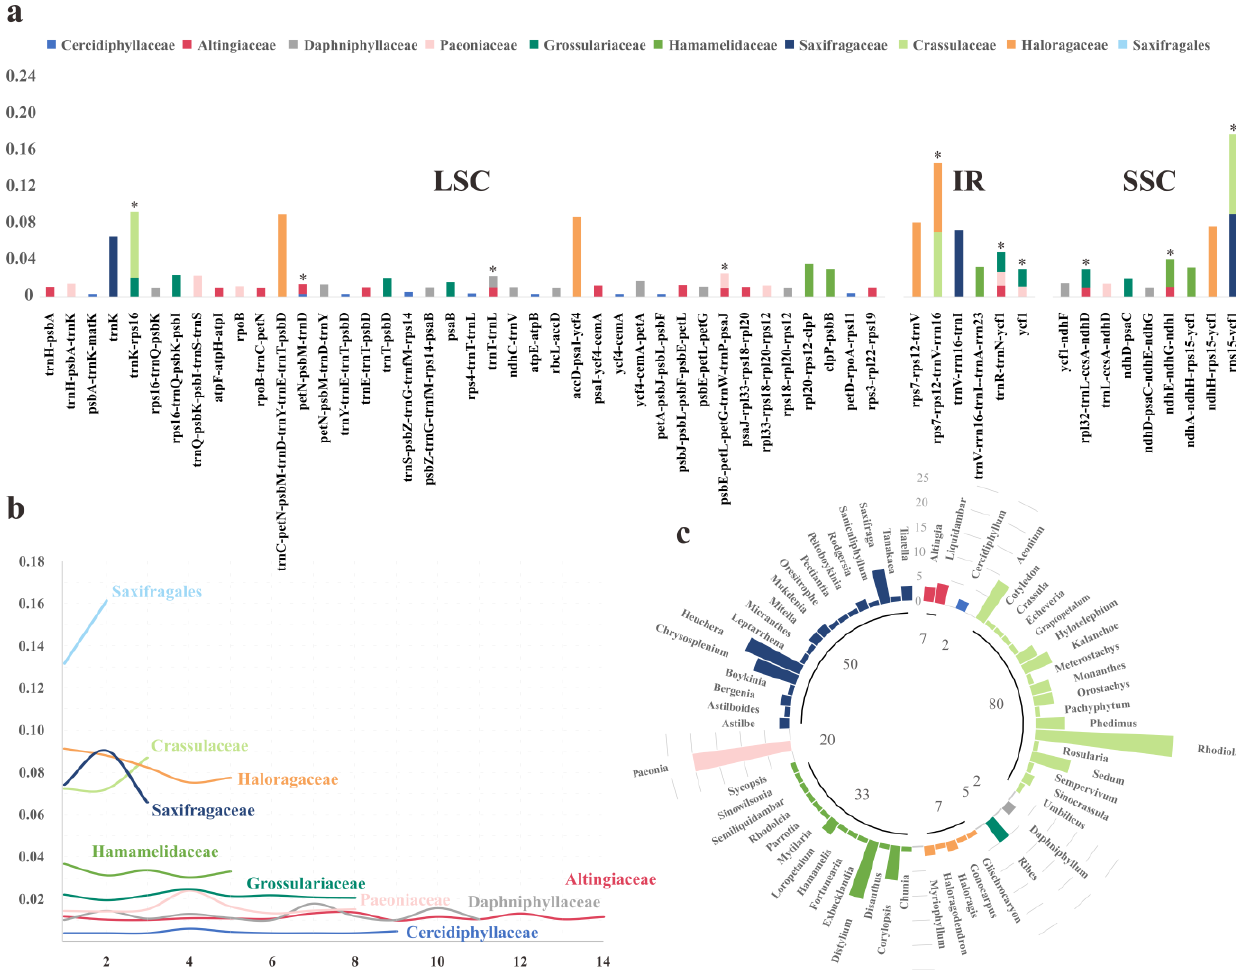
Figure 1. The hotspots patterns among Saxifragales. ( a ) Distributions of all the identified HPR loci, the HPRs that were shared by multiple families were marked by *; ( b ) Patterns of π values of different lineages; ( c ) Taxon samplings of this analysis, with the numbers in the circle indicating the numbers of sampling plastomes in each family, the numbers and heights of columns represented the number of genera involved, and plastomes that contained in each